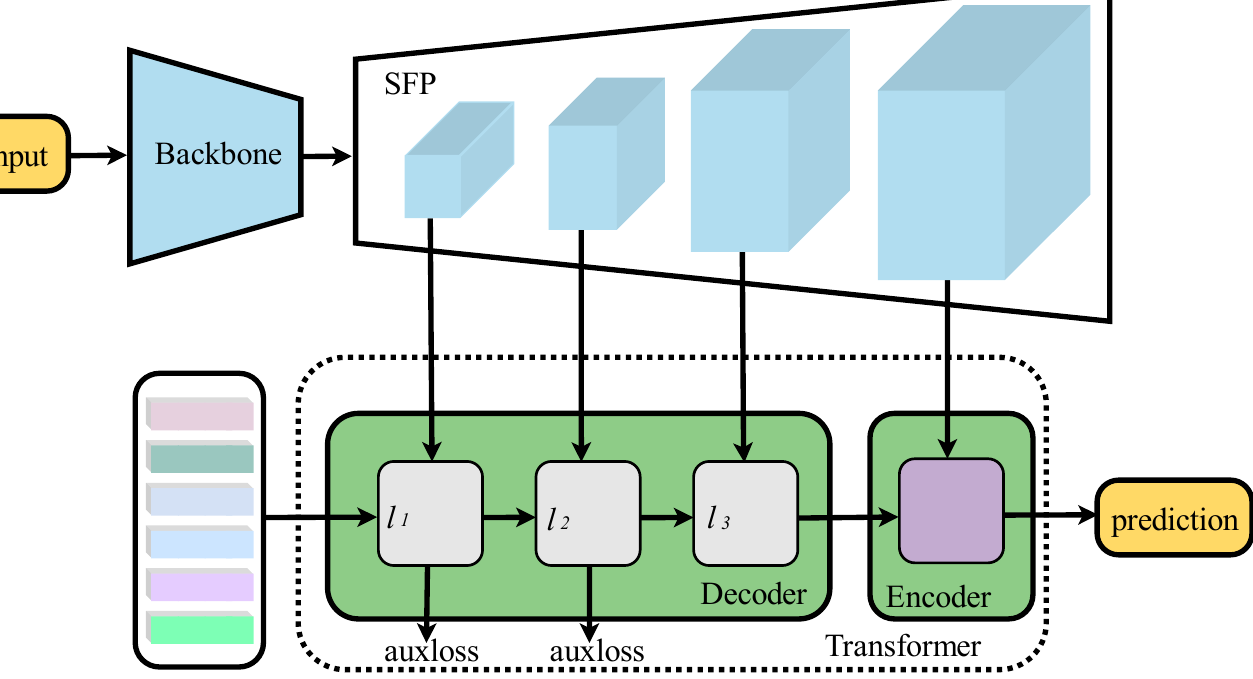
Figure 2. Neural Network overview. We propose an innovative transformer module with cross- attention that utilizes multiscale features from a pixel decoder (Section 3.3). Additionally, we proposed object embedding queries to aggregate class features (Section 3.2). Stage 4 in the SFP and transformer encoder layers for auxiliary loss are omitted in this figure for